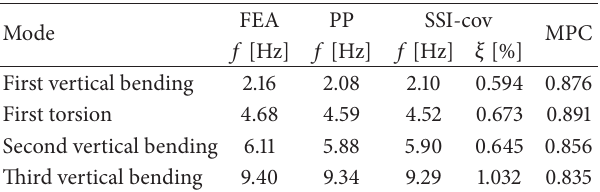
Table 1: The analytically and experimentally determined natural frequencies and damping